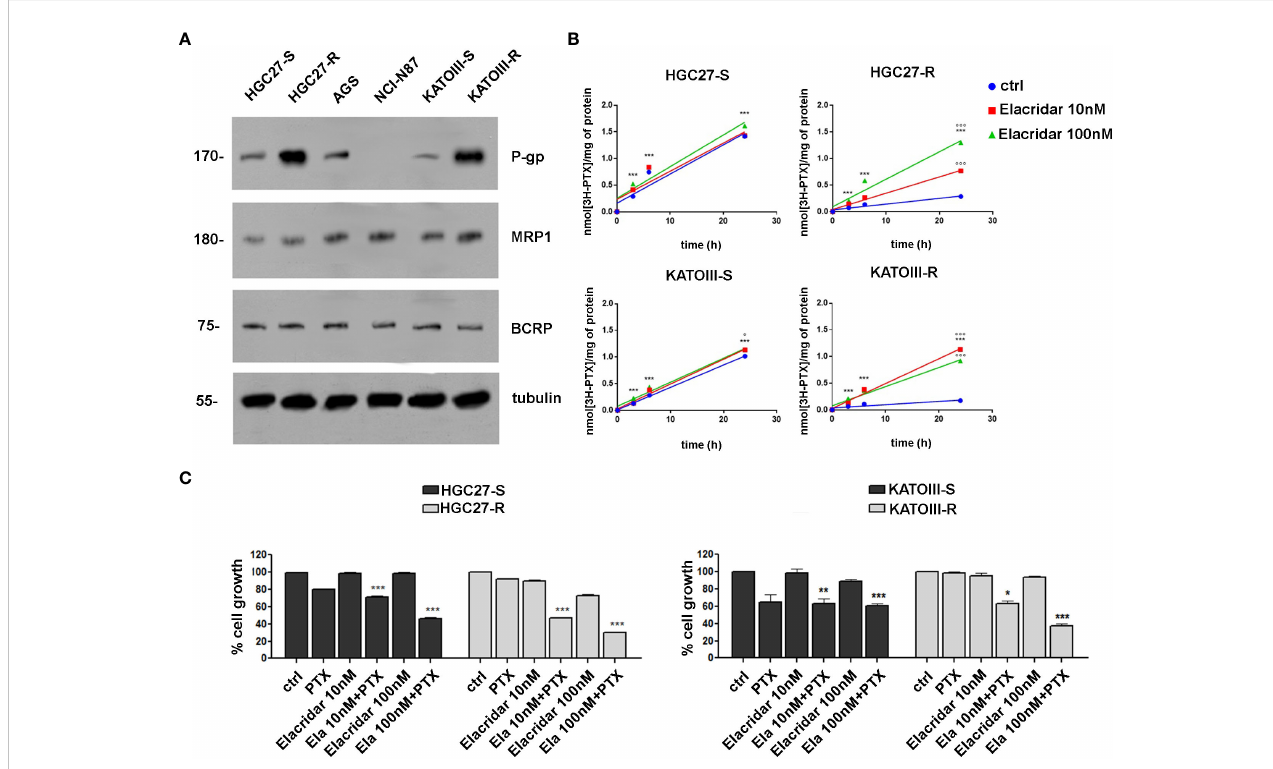
FIGURE 2 (A) Immunoblotting of ABC transporters in GC cell lines (HGC27-S/R, AGS, NCl-N87 and KATOIII-S/R). Whole cell lysates were subjected to immunoblotting for the indicated proteins. Tubulin was used as control of equal control loading. The fi gure is representative of 3 independent experiments; (B) accumulation of [3H]-PTX. HGC27-S/R and KATO-S/R were co-incubated for 1, 3, 6 and 24 hrs with 10 or 100 nM Elacridar plus 1 m Ci [3H]-PTX (co-incubation setting). The intracellular amount of [3H]-PTX was counted by liquid radio scintillation. Data are mean ± SD (n=3).